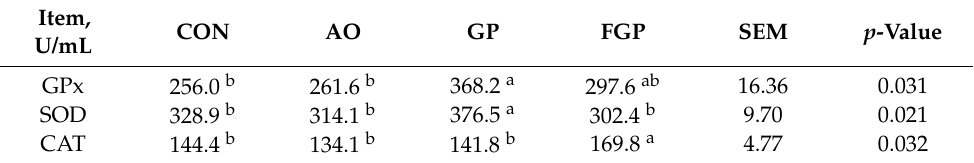
Table 5. Serum glutathione peroxidase, superoxide dismutase, and catalase of broiler chickens fed diets containing raw grape pomace, fermented grape pomace, and synthetic antioxidants 1 .